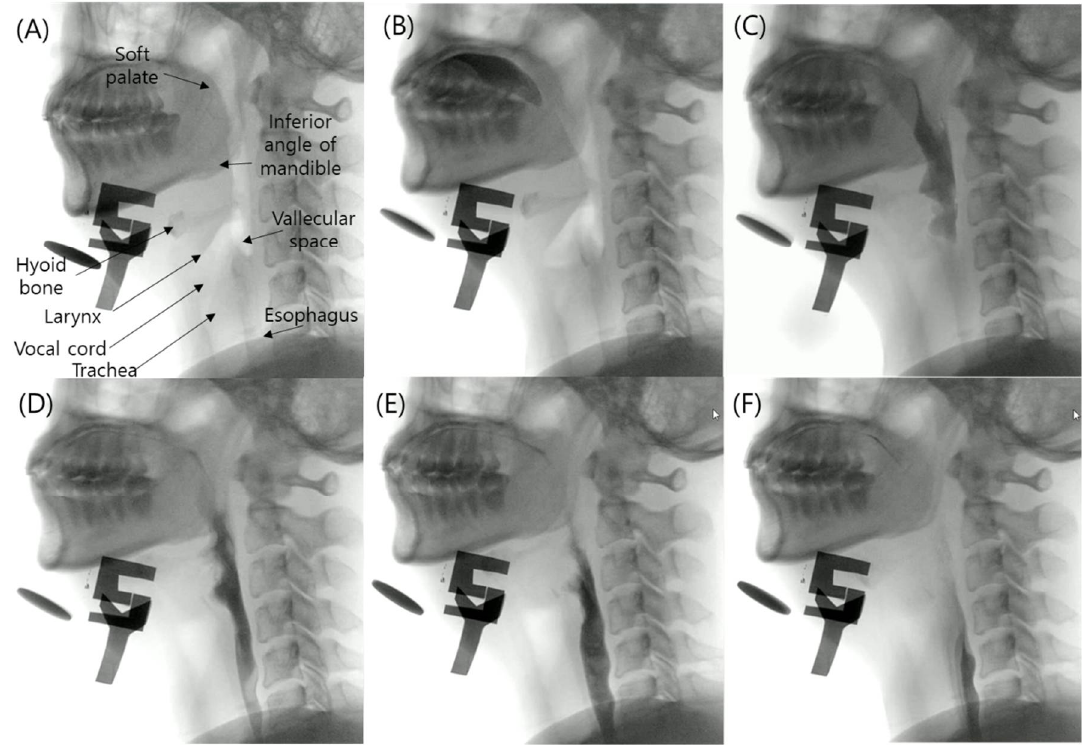
Figure 1. ( A ) Structural anatomy of normal swallowing of thick liquid bolus in ( B ) oral phase, ( C – E ) pharyngeal phase and ( F ) esophageal phase.